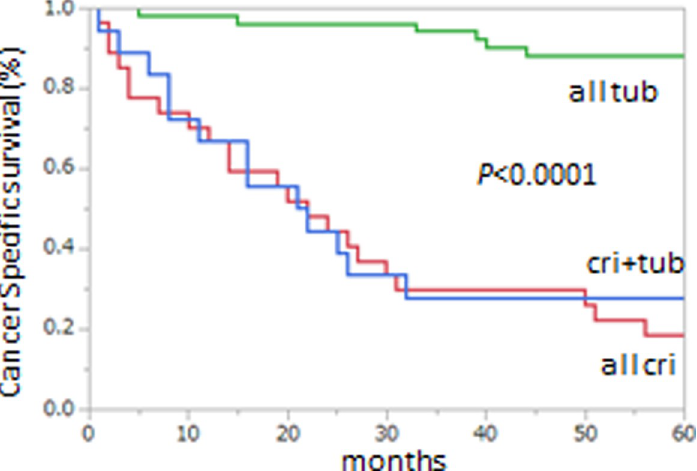
Fig 3. Kaplan–Meier plots of cancer-specific survival (CSS) in node-positive disease. CSS when all metastatic lymph nodes (mLNs) showed tubular carcinoma (“tub”), all mLNs showed cribriform carcinoma (“cri”), and some mLNs showed either tubular or cribriform carcinoma (“tub+cri”). All analyzed patients had a primary tumor classified as moderately differentiated adenocarcinoma.